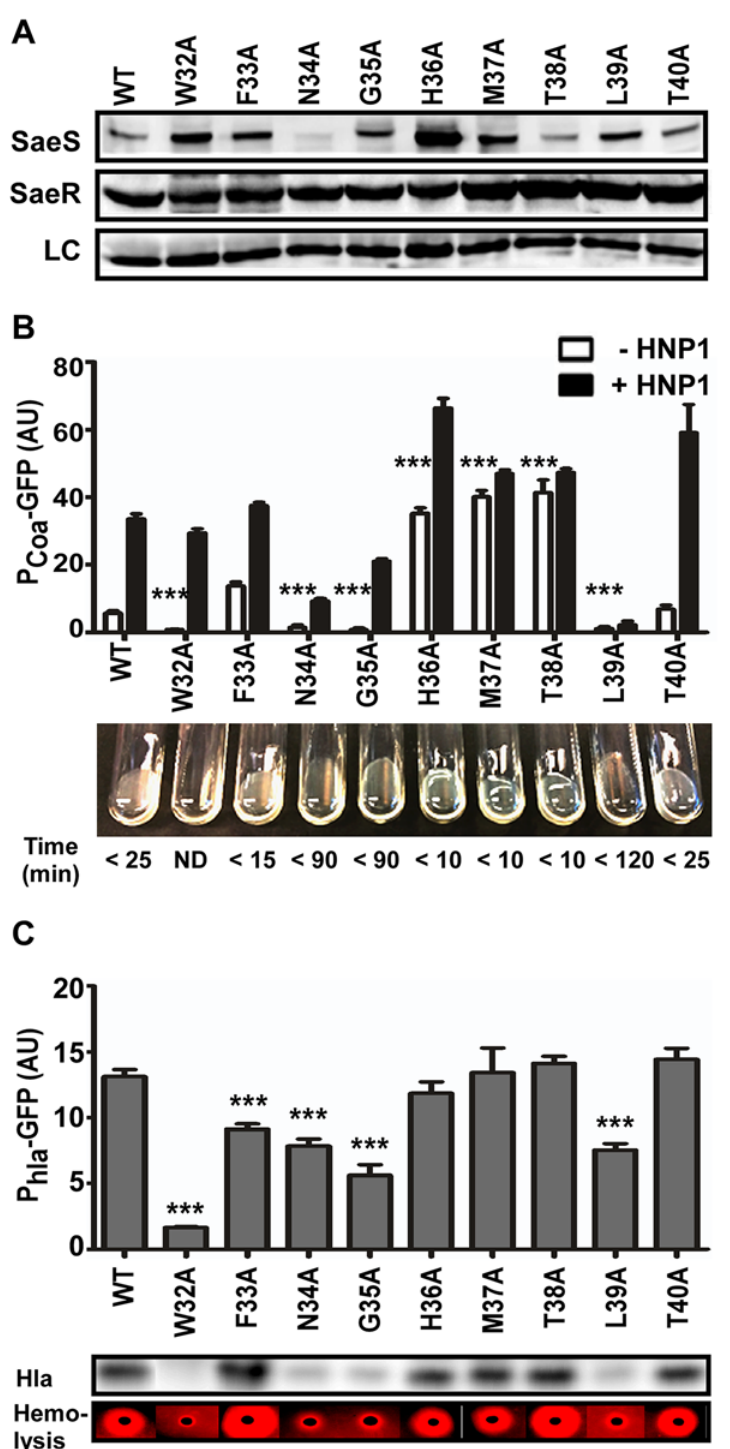
Fig 4. Alanine substitutions in the linker peptide alter the kinase activity of SaeS. (A) Expression of the alanine substitution mutants of SaeS analyzed by Western blot. An equal number of the cells were harvested at exponential growth phase. LC, loading control. (B) The effect of the alanine substitution mutations on the transcription of the low affinity target P coa and blood coagulating activity. The promoter activity of P coa was measured as described for Fig 2C. Coagulation activity was measured by mixing bacterial culture with